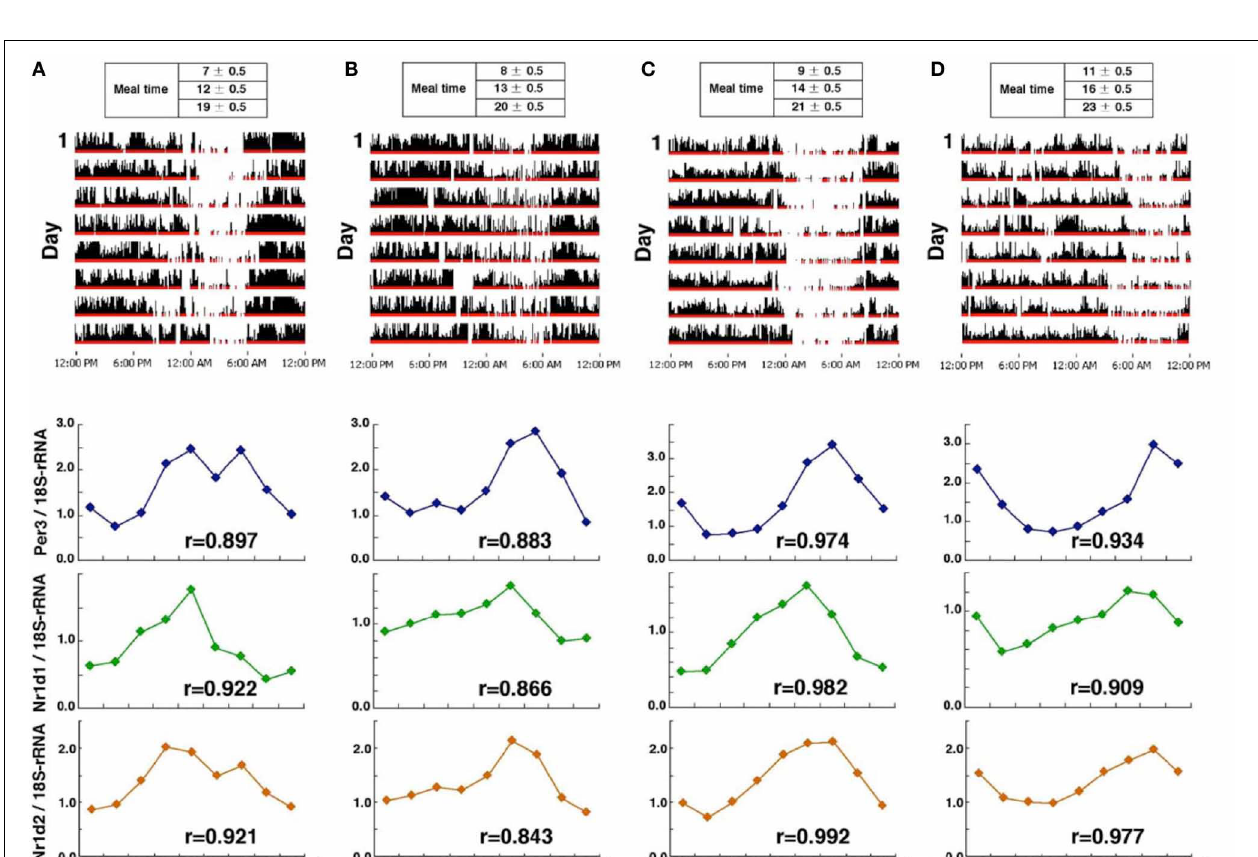
growth tends to extract a good deal of hair follicles. Pre-analysis, samples can be stocked in a deep freezer. The standard protocol for RT-PCR is adopted for the analysis. The graph in this diagram is adapted from Akashi et al. (2010).